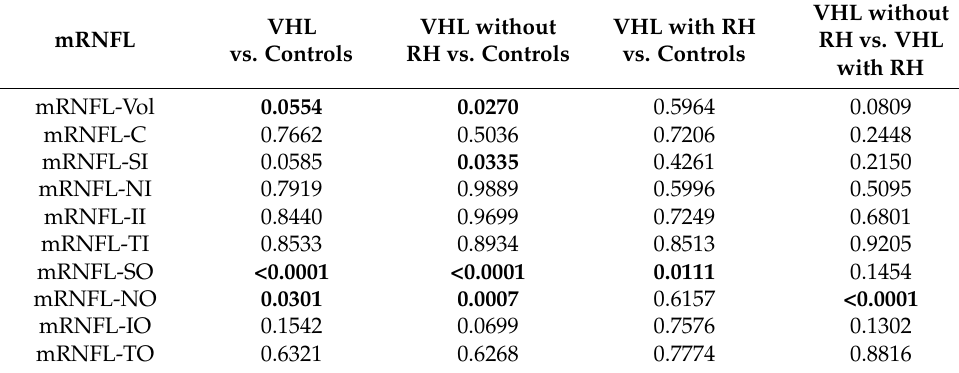
Table 5. Statistical significance ( p -value) of mRNFL thickness in the analyzed